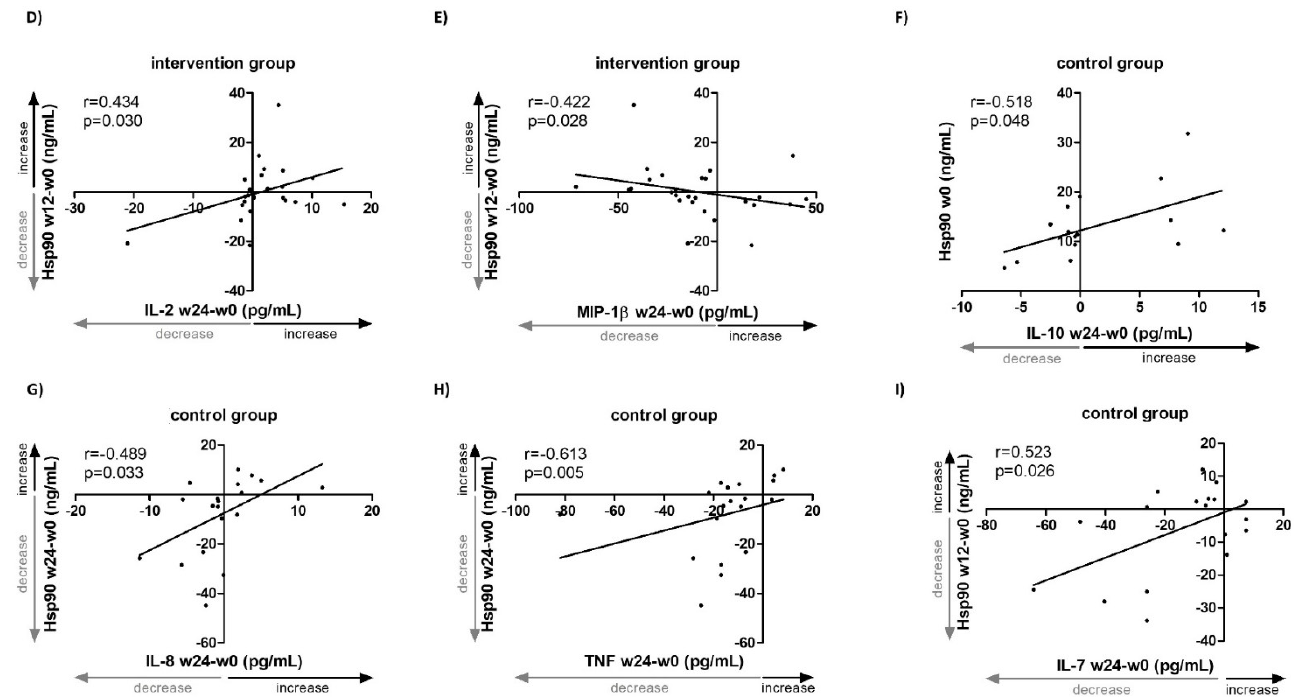
Figure 2. Associations of changes in systemic levels of Hsp90 and selected inflammatory cytokines/chemokines in patients with idiopathic inflammatory myopathies treated with standard-of-care pharmacotherapy (control group, CG, n = 23) or with additional non-pharmacological intervention (intervention group, IG, n = 27) for 24 weeks. Lower baseline plasma Hsp90 levels in IG predicted an increase in serum IL-10 ( A ) and a decrease in MIP-1 β ( B ) over weeks 0–24. ( C ) Changes in plasma Hsp90 levels in IG over weeks 0–24 correlated positively with changes in serum IL-6 over weeks 0–24. Changes in plasma Hsp90 levels in IG over weeks 0–12 correlated positively with changes in serum IL-2 ( D ) and negatively with MIP-1 β ( E ) over weeks 0–24. ( F ) Lower baseline plasma Hsp90 levels in CG predicted a decrease in serum IL-10 over weeks 0–24. Changes in plasma Hsp90 levels in CG over weeks 0–24 correlated positively with changes in serum IL-8 ( G ) and TNF ( H ) over weeks 0–24. ( I ) Changes in plasma Hsp90 levels in CG over weeks 0–12 correlated positively with changes in serum IL-7 over weeks 0–24. W, week.